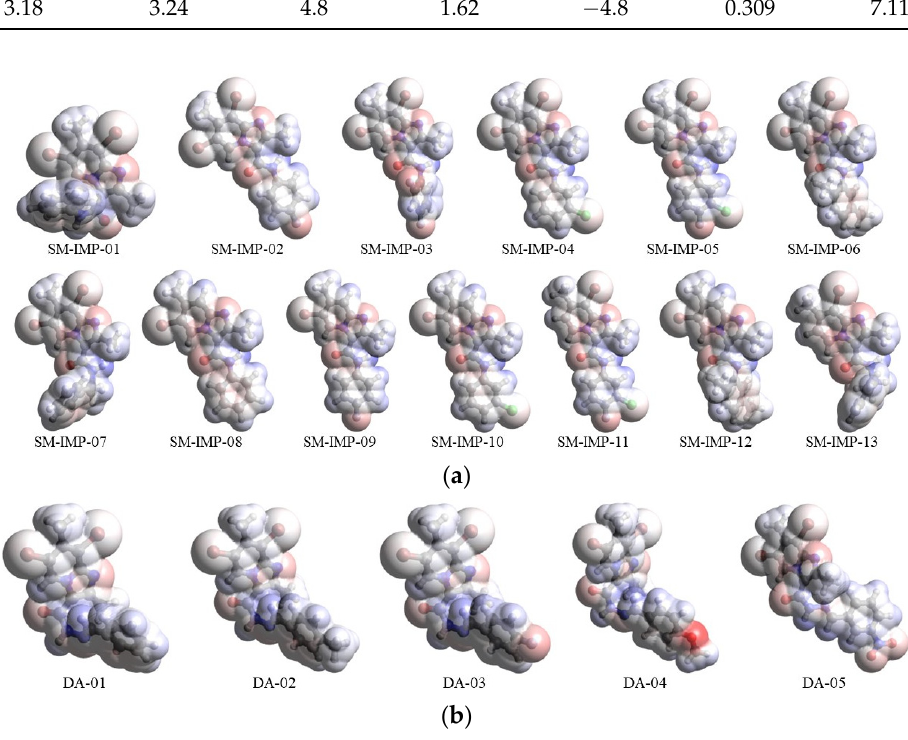
Figure 4. Molecular electrostatic potential (MEP) maps for the investigated compounds: series SM-IMP-01–SM-IMP-13 ( a ) and DA-01–DA-05 ( b ), B3LYP/6-311+G(d,p), implicit water.